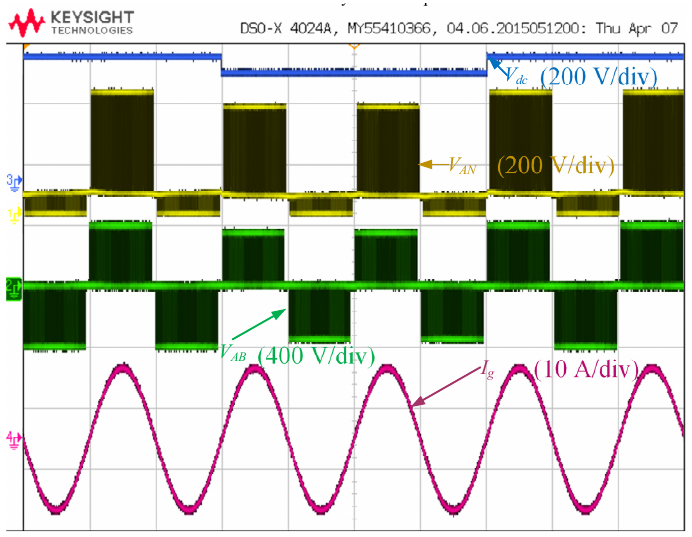
Figure 16. Dynamic response of the proposed transformer-less inverter with the step change in the DC input voltage. DC input